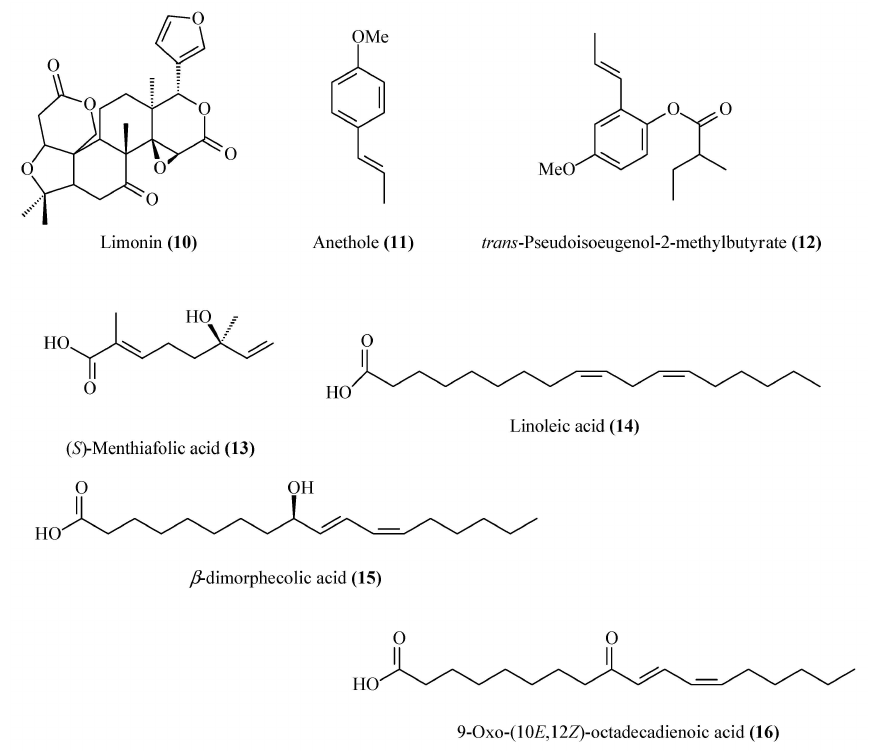
Figure 2. Structures of limonoid 10 , phenylpropanoids 11 and 12 , and acids 13 – 16 isolated from the citrus waste of Citrus sinensis